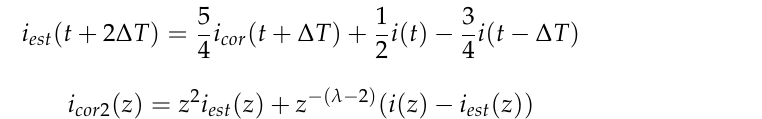
The principle of small-step interpolation is shown in Figure 7.